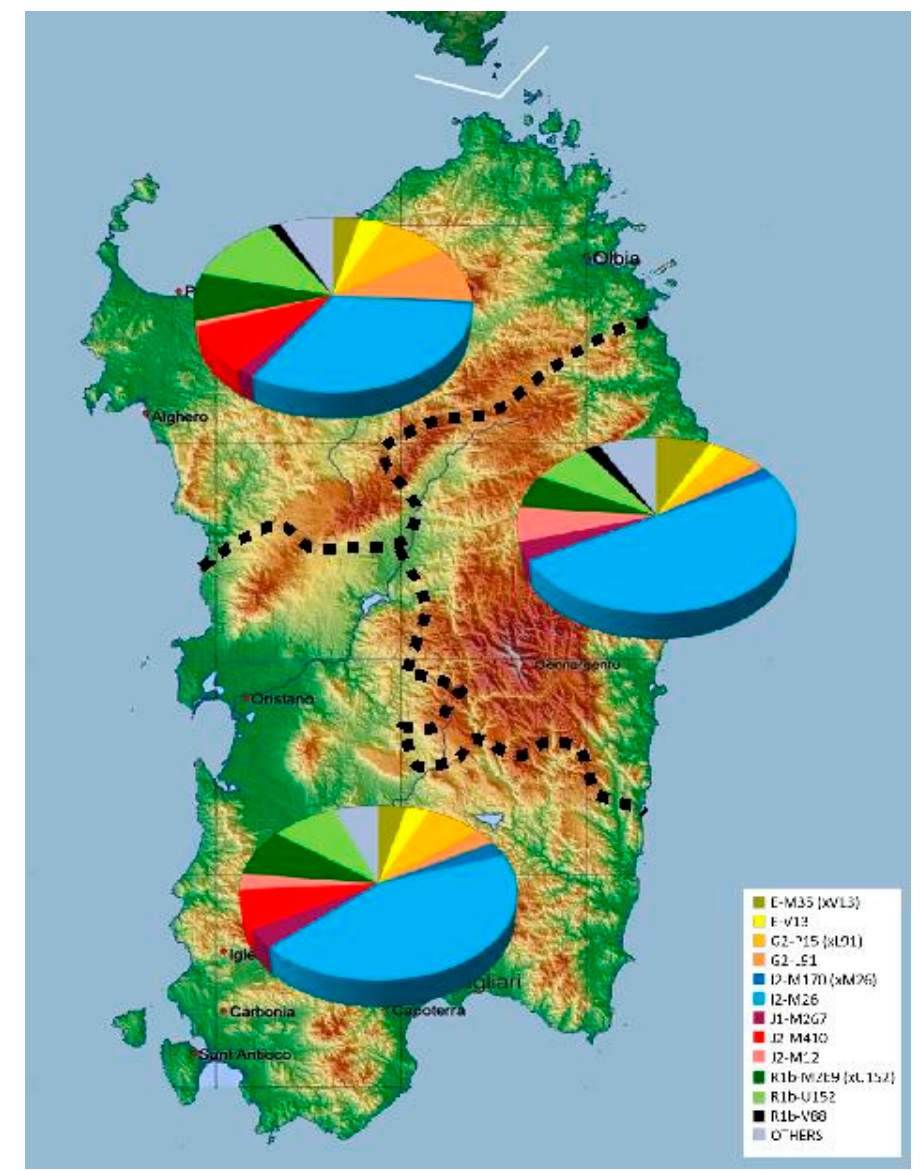
Figure 2. Proportion of the observed Y-chromosome haplogroups in the three main cultural and geographical areas of Sardinia. Dashed lines indicate boundaries of the three main areas.